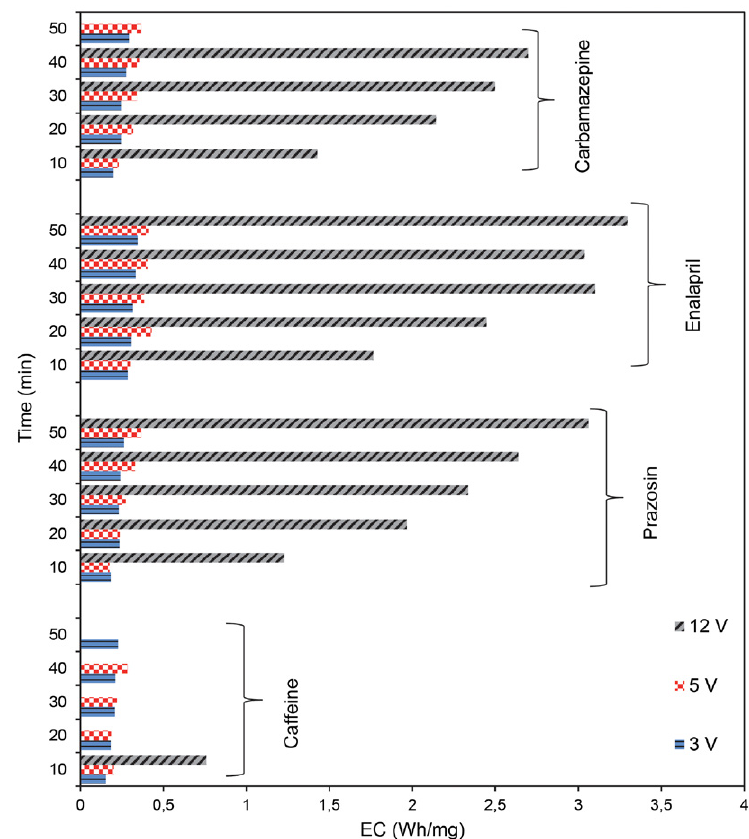
Figure 4. Effect of applied voltage on the energy consumption at 5 mg/L and 2 g/L